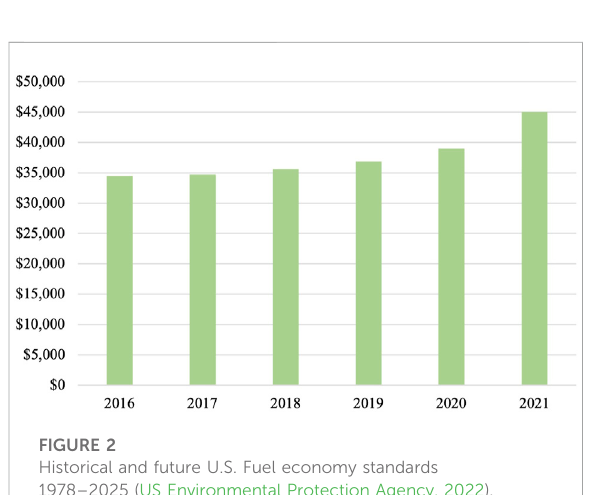
FIGURE 2 Historical and future U.S. Fuel economy standards 1978 – 2025 (US Environmental Protection Agency,